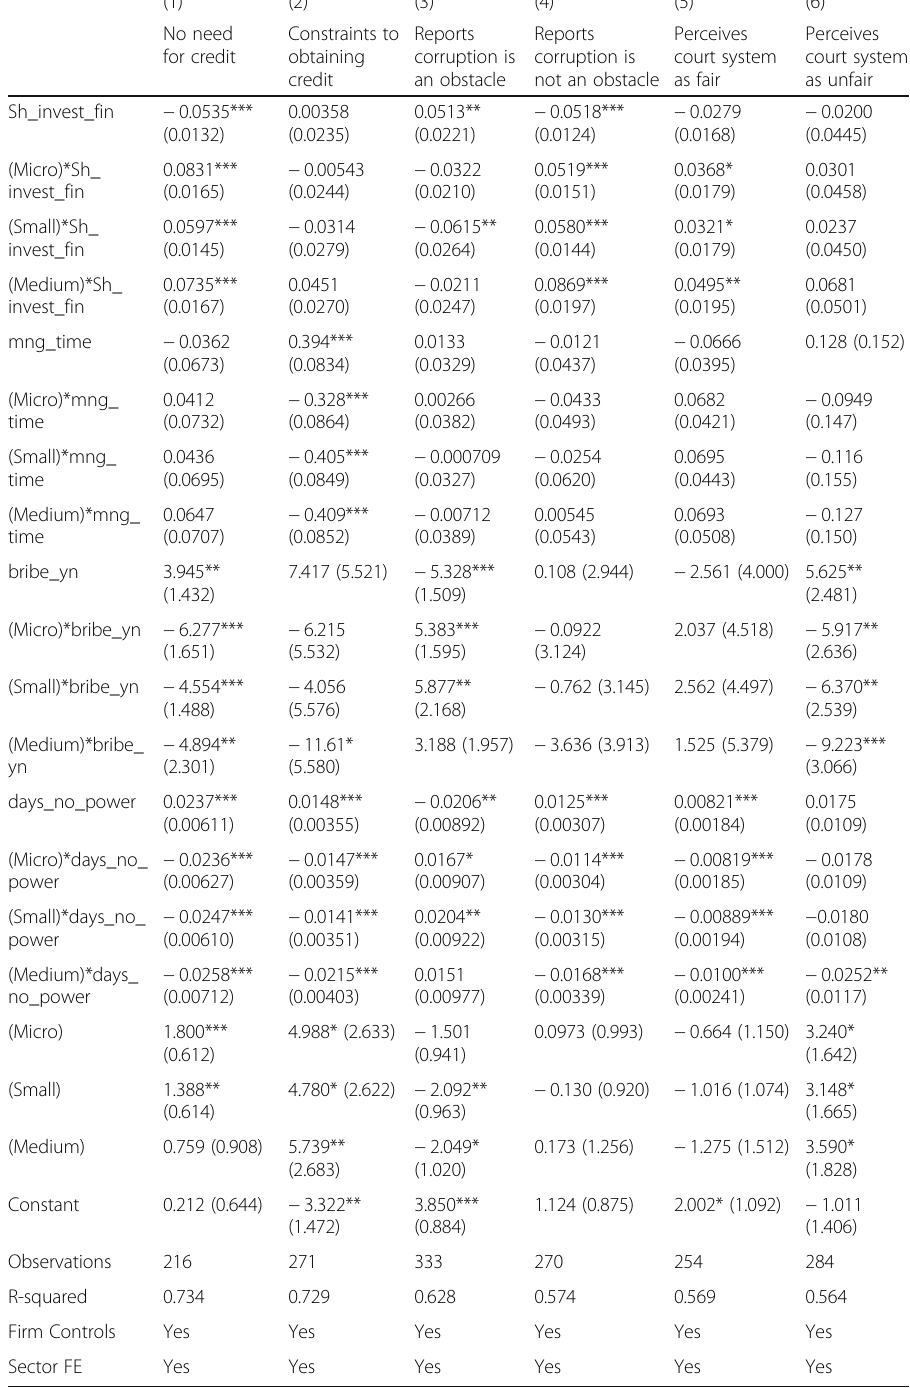
Table 5 Institutional